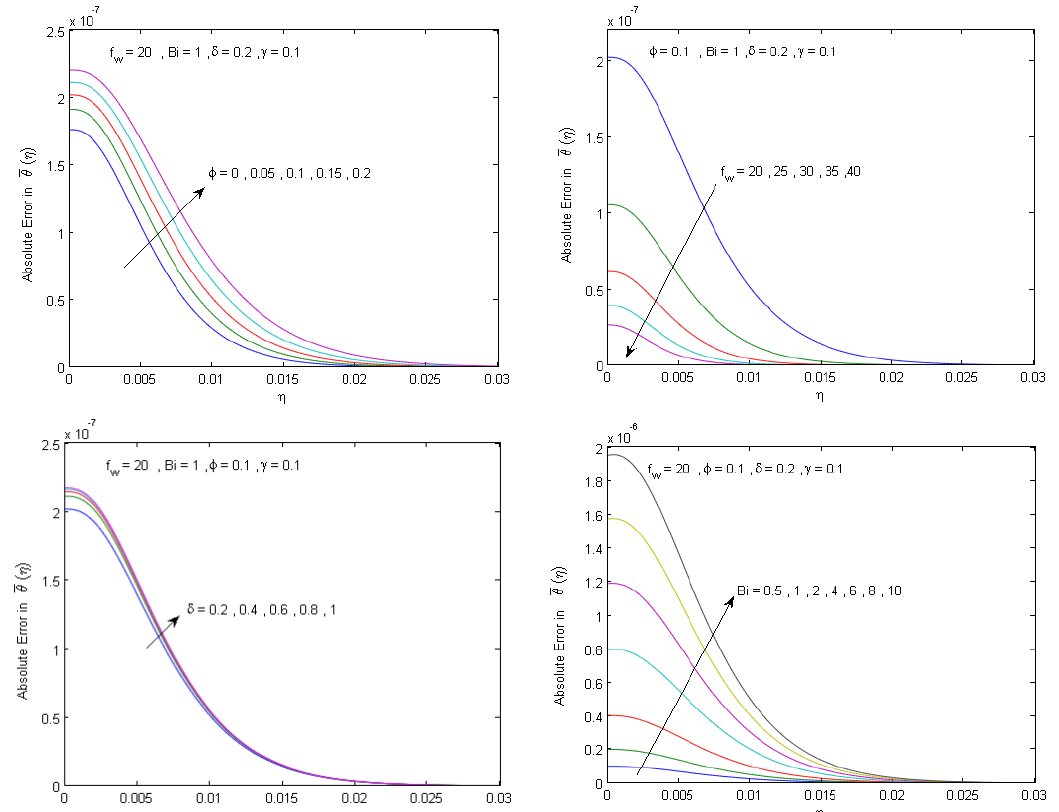
Figure 2. The effect of the physical parameters f w , φ , Bi , and δ on the absolute error of the obtained analytical solution θ ( η ) .